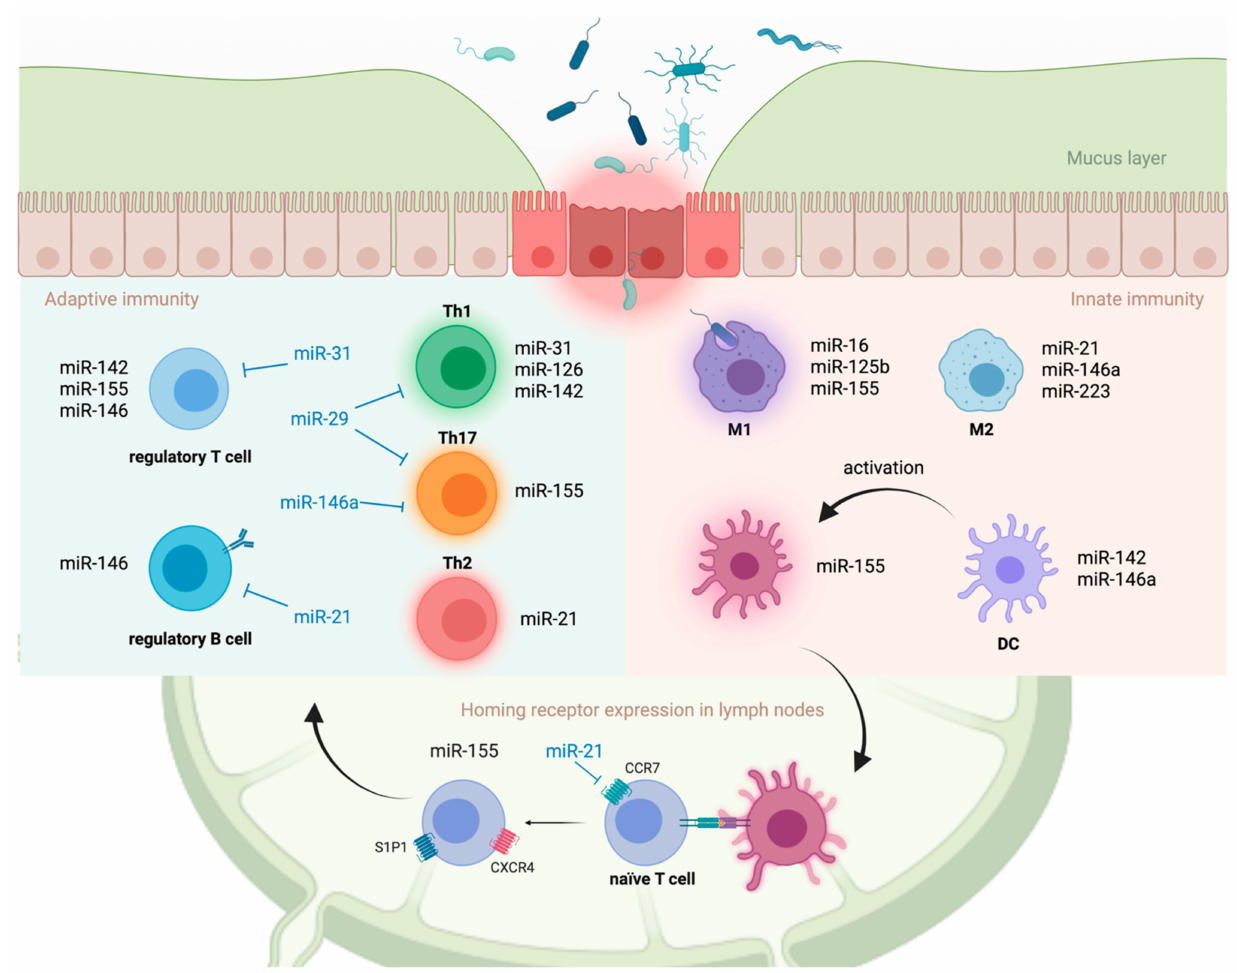
Figure 3. Potential roles of UC-associated miRNAs in aberrant mucosal immune response. MiRNAs with suppressive function are highlighted in blue. M1, M1 macrophage; M2, M2 macrophage; DC, dendritic cell; Th, helper T cell; CCR6, chemokine receptor 6; CXCR4, C-X-C motif chemokine receptor 4; S1P1, sphingosine-1-phosphate receptor